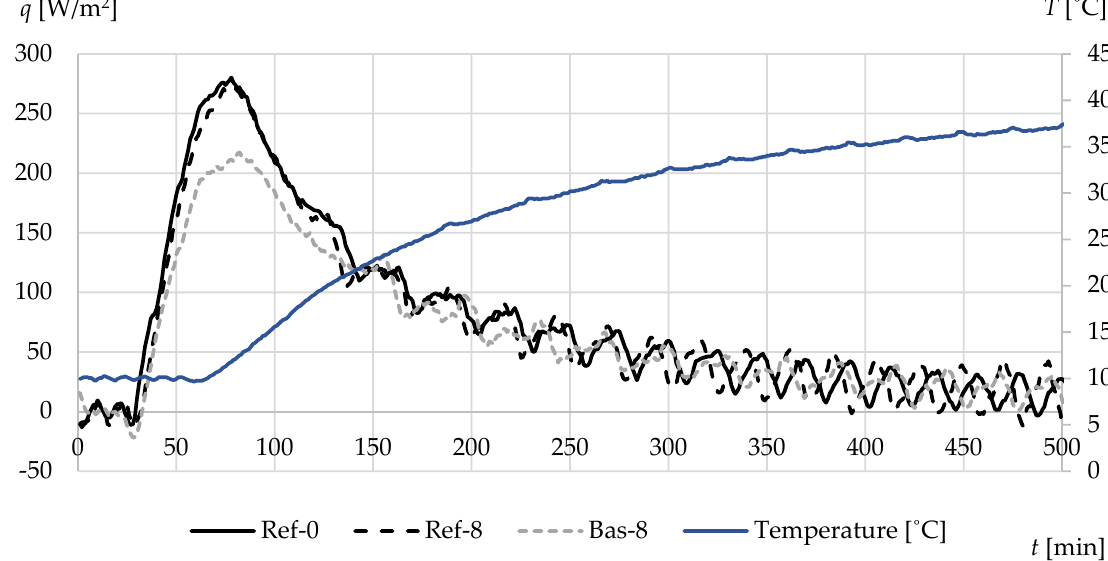
Figure 13. The average heat fluxes at a depth of 3.4 cm during heating from 10 to 40 °C.